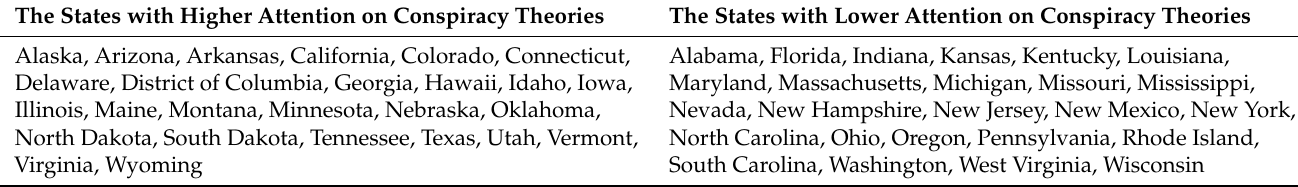
Table A2. The states and district in the United States sorted according to their online attention values on the COVID-19- related conspiracy